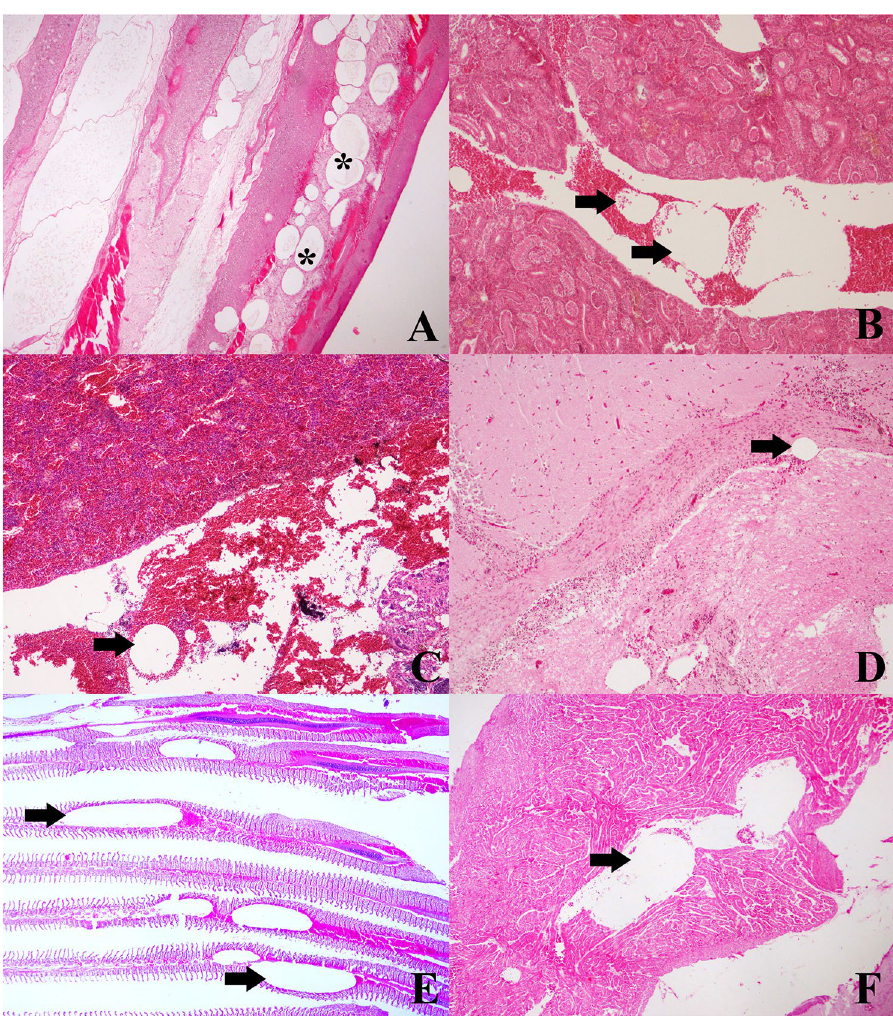
Figure 8. Microscopic findings of the 18-h fish group stained routinely with hematoxylin–eosin. ( A ) Fins displays the presence of emphysema (stars) and congestion. ×4. ( B ) Posterior kidney with large, unstained, circular to oval structures between blood components (arrows). ×10. ( C ) Gas bubble-like in the spleen (arrow), along with congestion. ×10. ( D ) Congestion and dilatation of blood vessels in the brain (arrow). ×10. ( E ) Blood vessels of primary gill lamellae with large caliber bubble-like gas, circumscribed by blood cells (arrows). ×4. ( F ) Ventricle cavity of the heart with presence of displaced blood around an oval, unstained structure compatible with gas bubble (arrow).